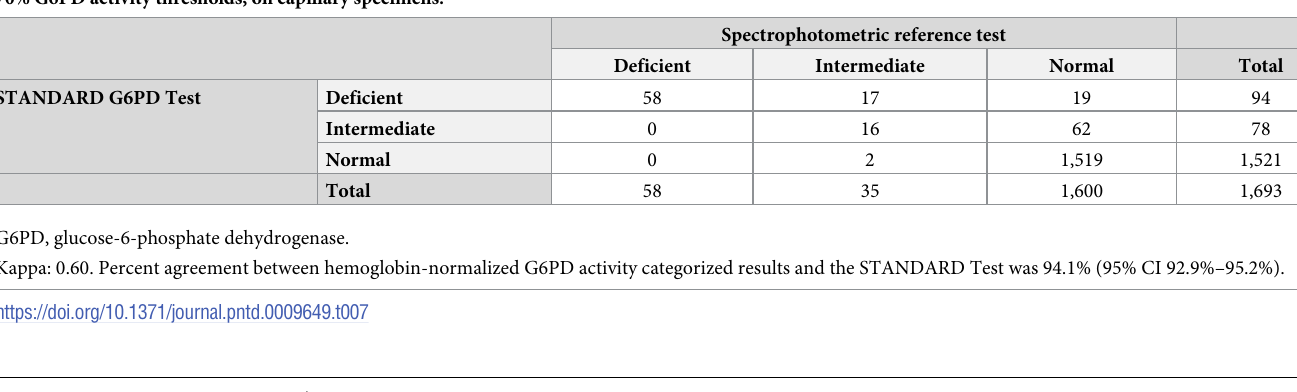
Table 7. Percent agreement between the STANDARD G6PD Test and the spectrophotometric reference test using the manufacturer’s threshold values at 30% and 70% G6PD activity thresholds, on capillary